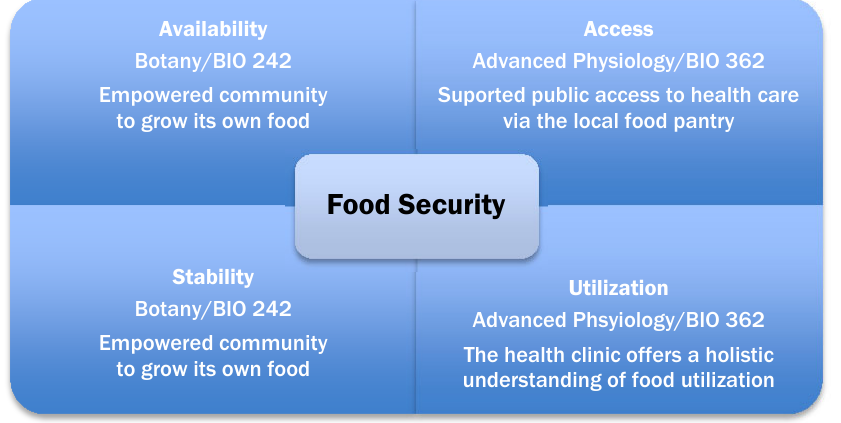
Figure 1. Components of Food Security According to the Food and Agriculture Organization of the United Nations (FAO) and